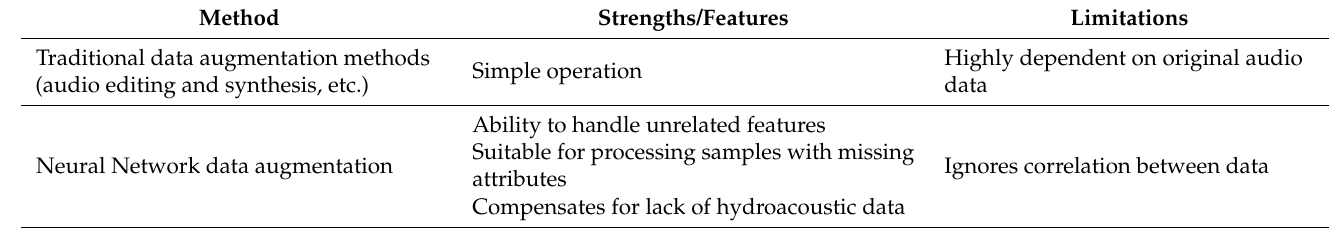
Table 3. Data augmentation